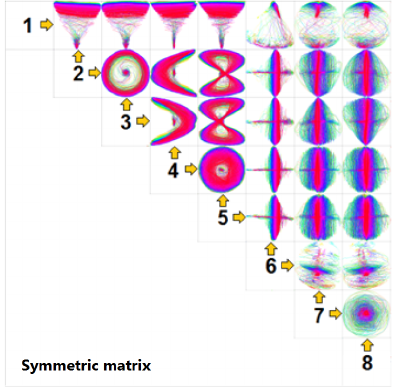
Figure 14. Similarity plot matrix of 8-dimensional MDS projection for the astrophysical simulation ensemble (45 simulations differently color coded) with 28 different combinations of 8 dominant eigenvectors.